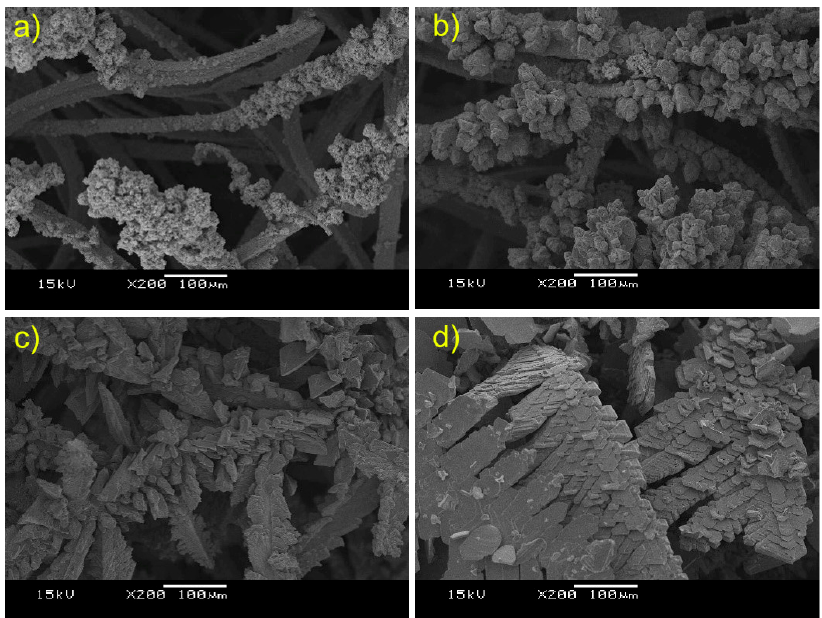
Figure 7. SEM micrographs of the Zn/IF surface (200×), at deposition potentials of ( a ) − 1.60 V vs. Hg/HgO, ( b ) − 1.55 V vs. Hg/HgO, ( c ) − 1.50 V vs. Hg/HgO and ( d ) − 1.45 V vs. Hg/HgO for 30 min in an electrolyte solution.